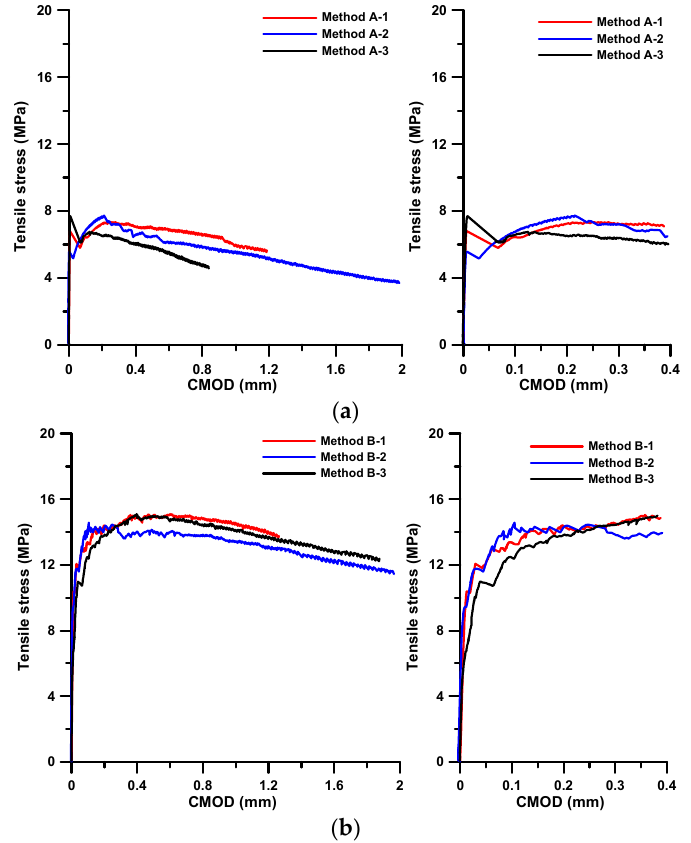
Figure 3. Tensile stress-CMOD curves for ( a ) Method A; and ( b ) Method B. Table 3. Results of the direct tensile test.